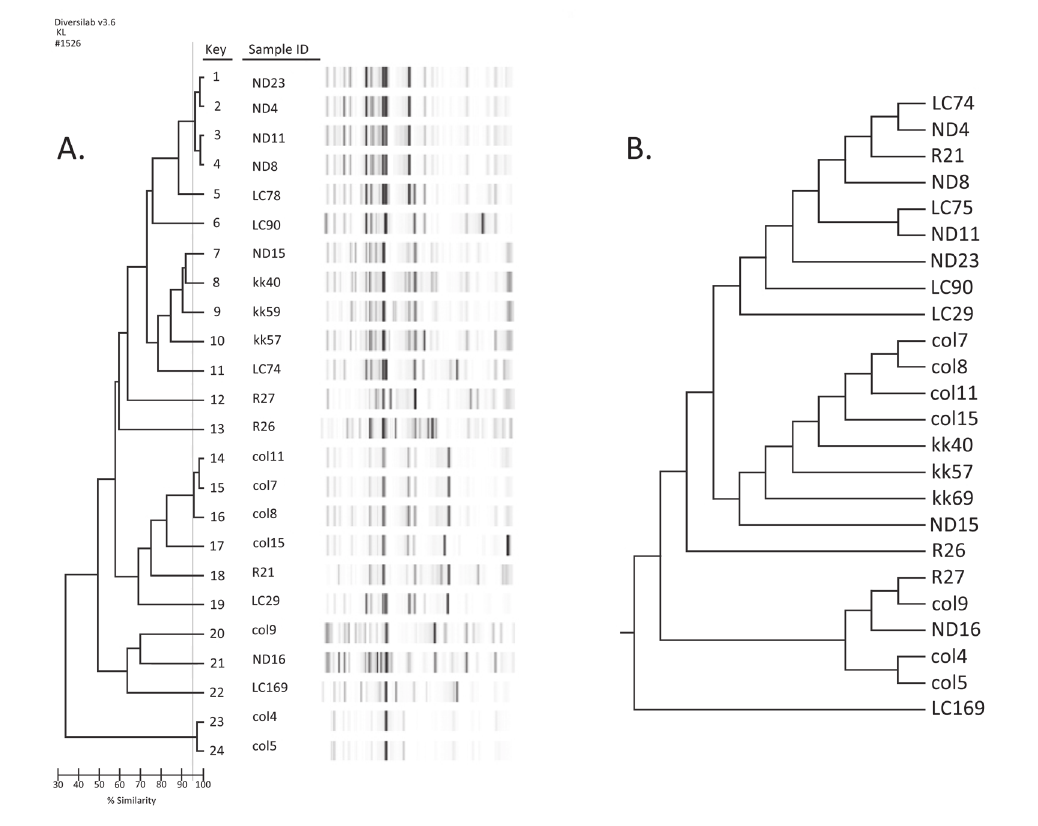
Figure 3. Isolates on which MLST was performed. A. Phylogenetic tree by rep-PCR; B. phylogenetic tree by hsp60